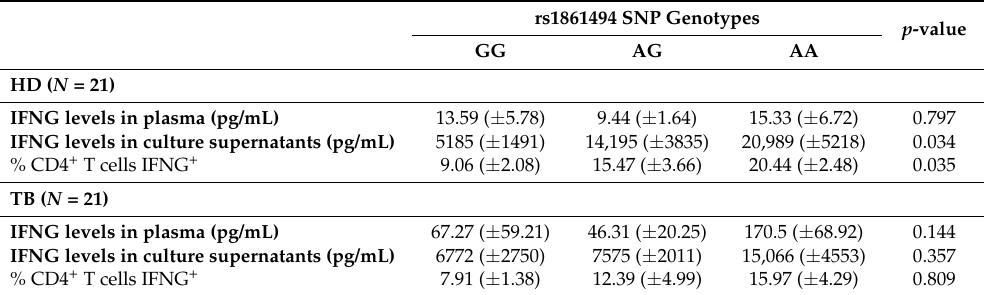
Table 3. Association between the IFNG rs1861494 single nucleotide polymorphism (SNP) genotypic variants and IFNG production in the context of